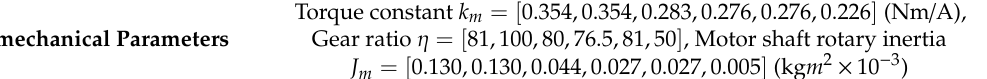
Table 2. Robot controller